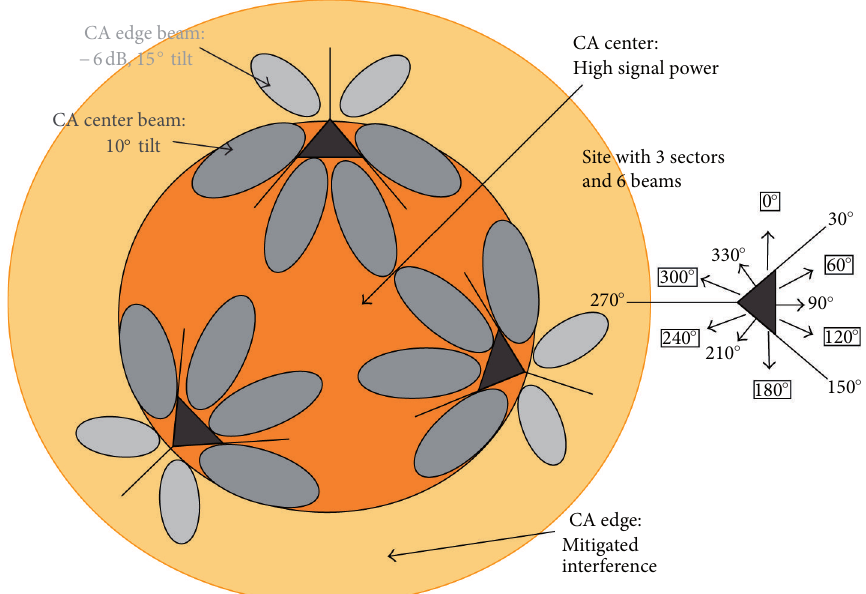
Figure 1: The complete interference mitigation framework consists of three adjacent sites. Multiple antennas at each of the cooperating BSs perform wideband beamforming to steer the signal more towards the CA’s center.